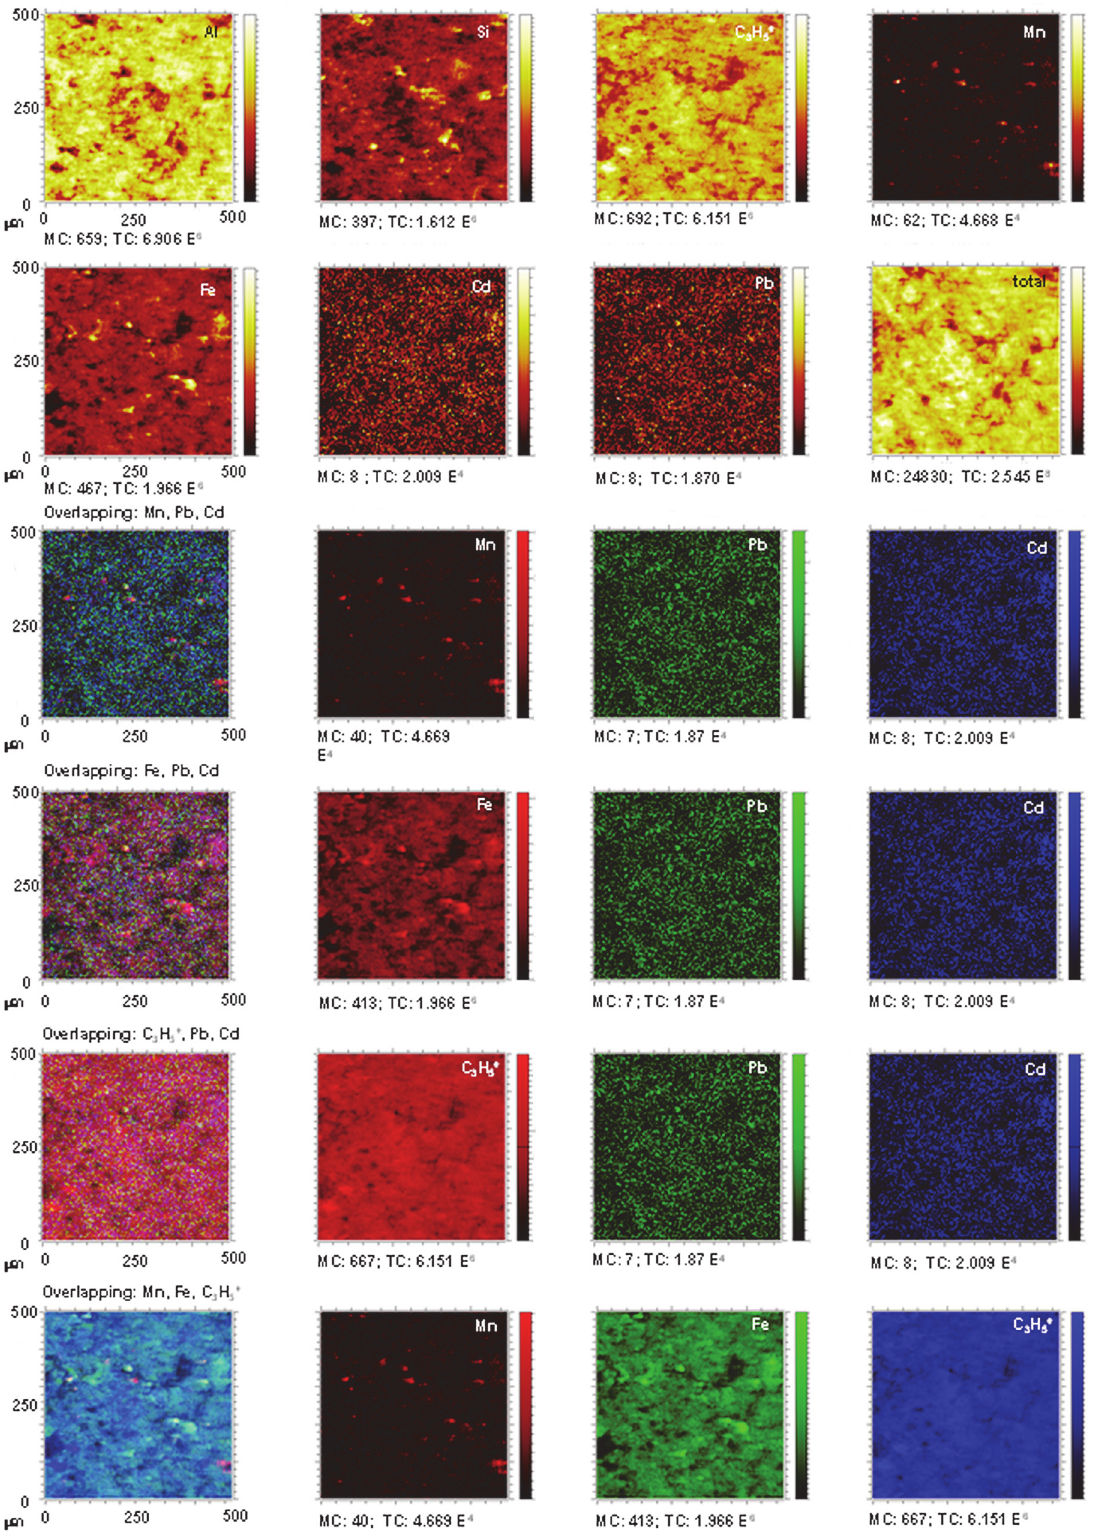
Fig 3. Untreated DU.Bw horizon. TOF-SIMS images of Al, C 3 H 5+ ,Si, Fe, and Mn ions, and overlapping all the signals with Pb 2+ and Cd 2+ . Images of overlapping: Mn + Pb + Cd; Fe + Pb + Cd; C 3 H 5+ + Pb + Cd; and Mn + Fe + C 3 H 5+ showing the concordance between signals. doi:10.1371/journal.pone.0123977.g003 PLOS ONE | DOI:10.1371/journal.pone.0123977 April 20,